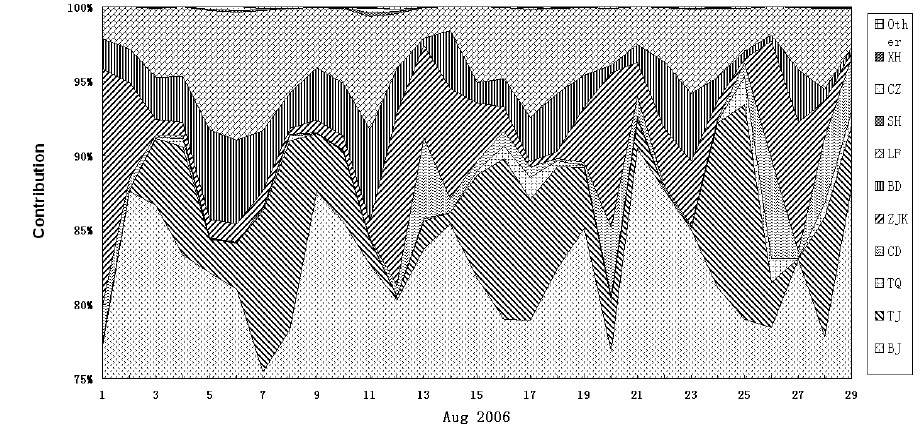
Fig. 9. Percentage of the contributions to the daily mean primary PM 10 concentration in Beijing at the surface layer. www.atmos-chem-phys.net/11/5997/2011/ Atmos. Chem. Phys., 11, 5997–6011,